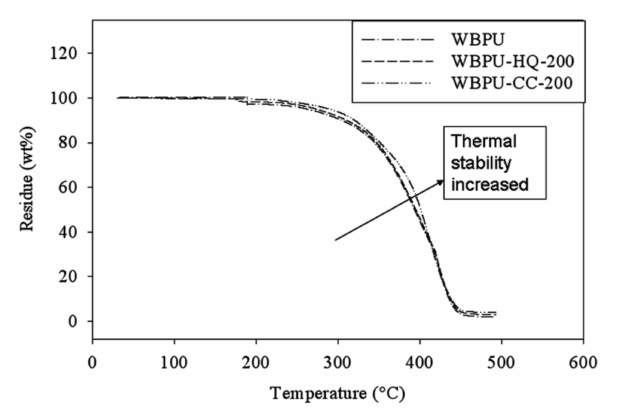
Figure 8. Typical TGA curves of